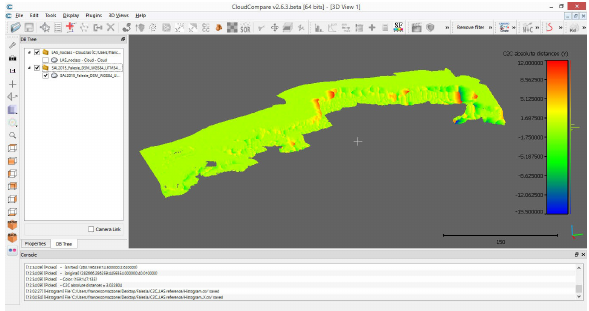
Figure 11: Distances between UAV and LIDAR point clouds.